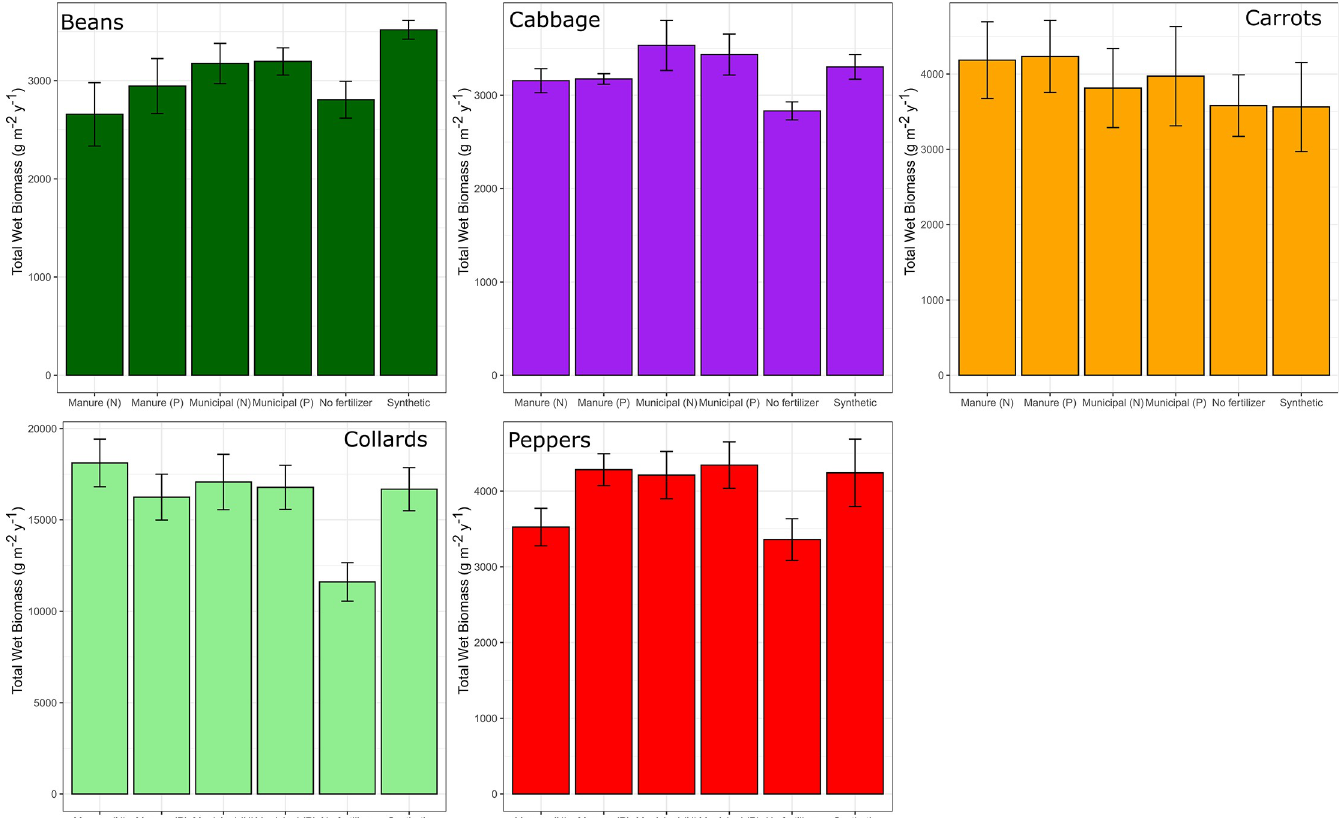
Fig 2. Mean total crop yield wet biomass (g m -2 y -1 ) combined for years 2017 and 2018 across the different treatments for each crop type. Note differences in scales for each crop.